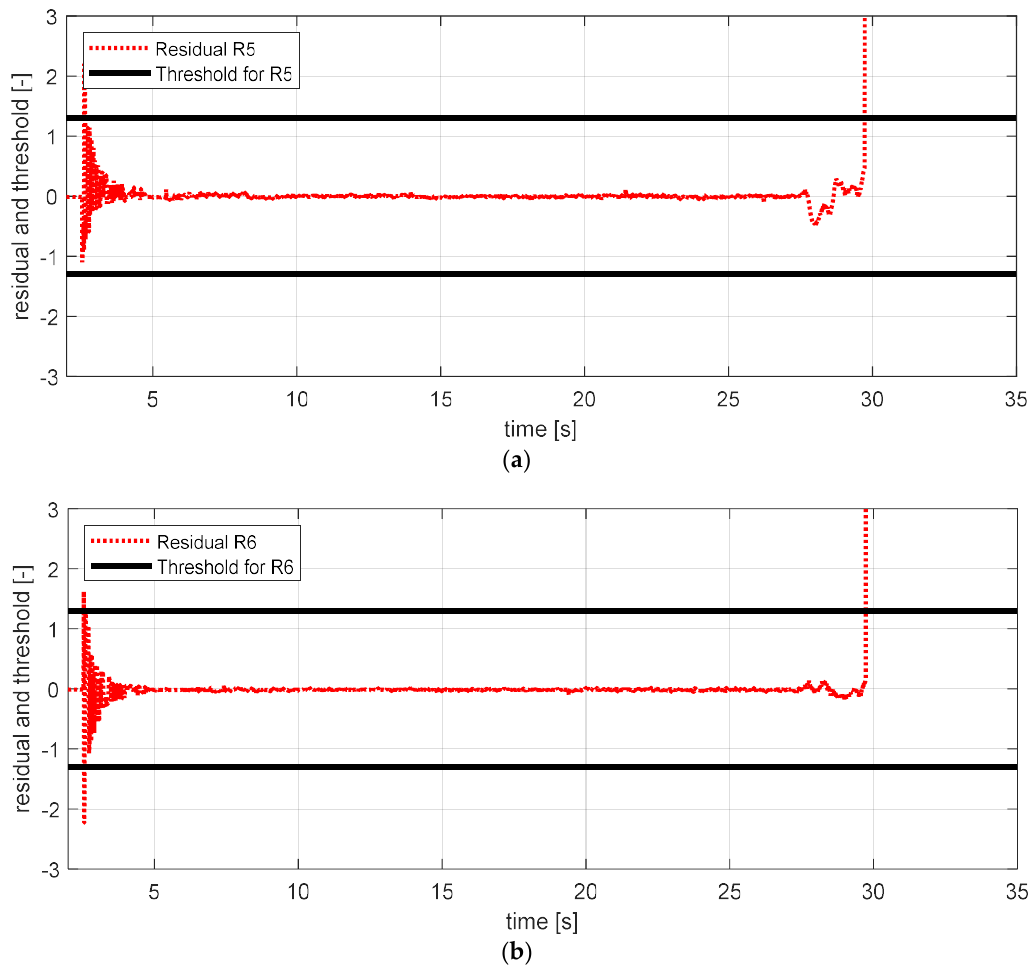
Figure 28. Simulation result for a steering wheel angle sensor (fault). ( a ) Residual 5 and threshold; ( b ) residual 6 and threshold.